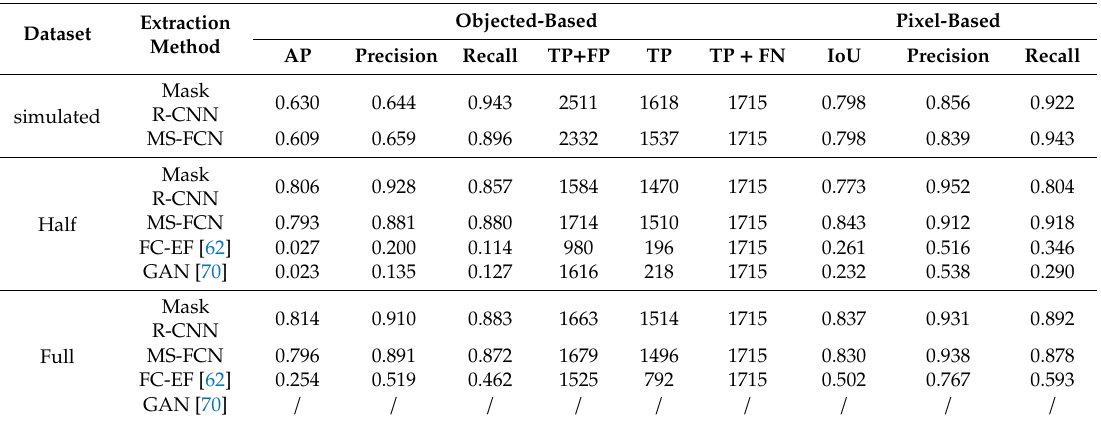
Table 3. Building change detection accuracy at the object level and pixel level under di ff erent training data: merely simulated data, half-change samples (within the green box in Figure 10) and full-change